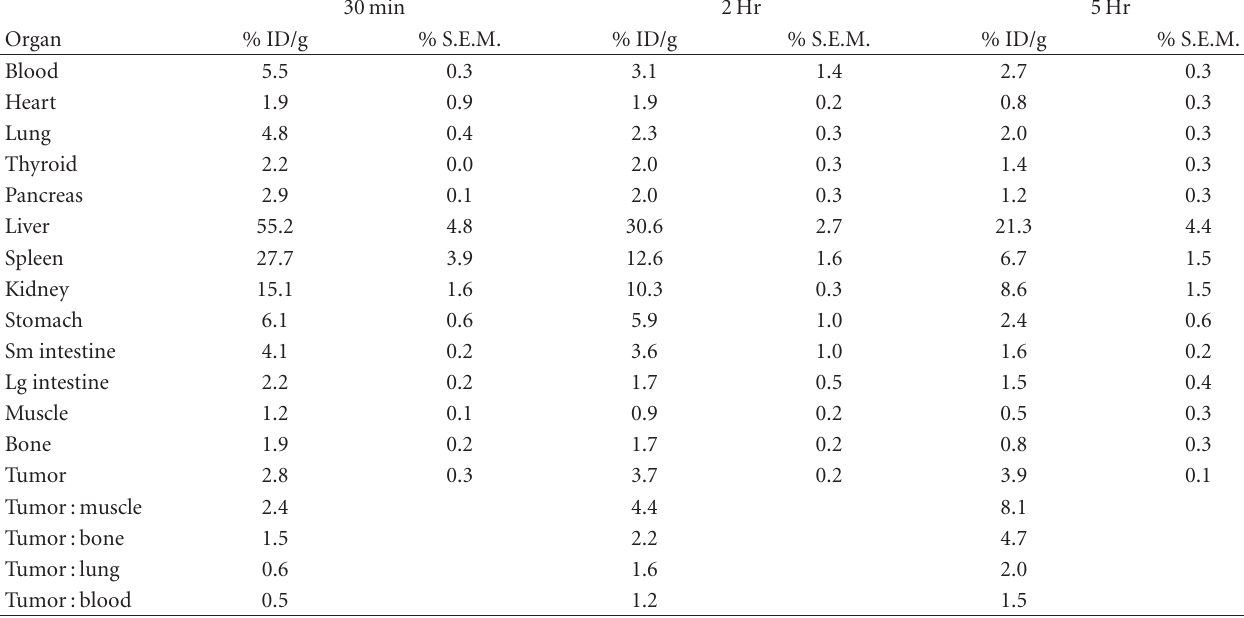
Table 1: Biodistribution of 131 I-SHH.